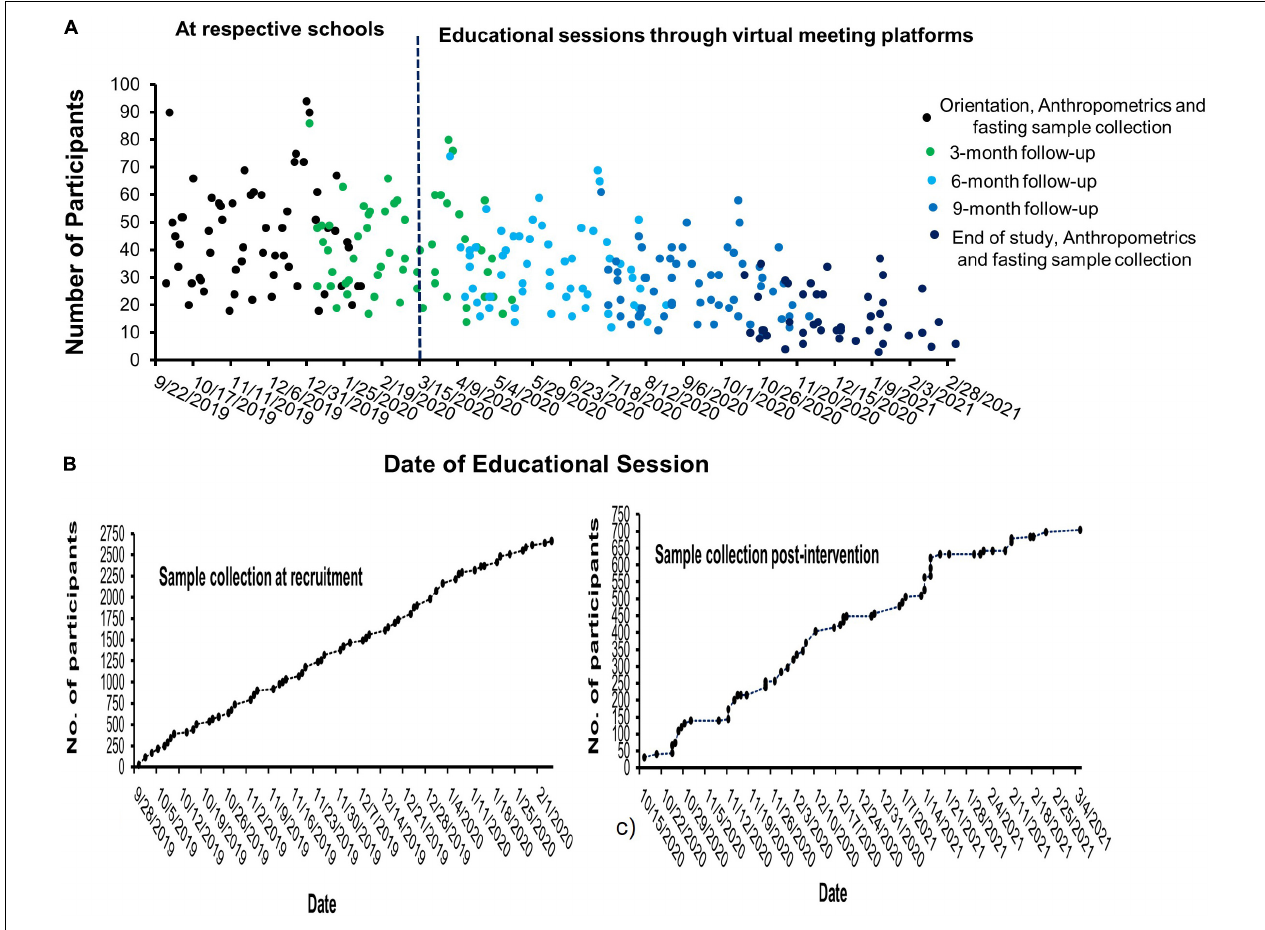
FIGURE 1 | Time series graph depicting the recruitment of participants and the educational sessions provided during the study period. In panel (A) , the number of participants recruited per session at the respective schools and their follow-up through virtual meeting platforms during the emergency of COVID-19 is depicted while panels (B) and (C) depict the blood samples collected at recruitment and end of study, respectively. TABLE 1 | Pediatric definition of